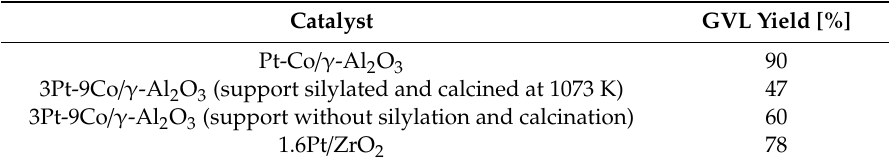
Table 1. Overview of GVL yields using di ff erent catalysts (batch experiments in the Parr mini-reactor with 0.3 g catalyst in 125 mL of aqueous solution with c LA = 22.06 g L − 1 , c FA = 27.16 g L − 1 , T = 493 K,